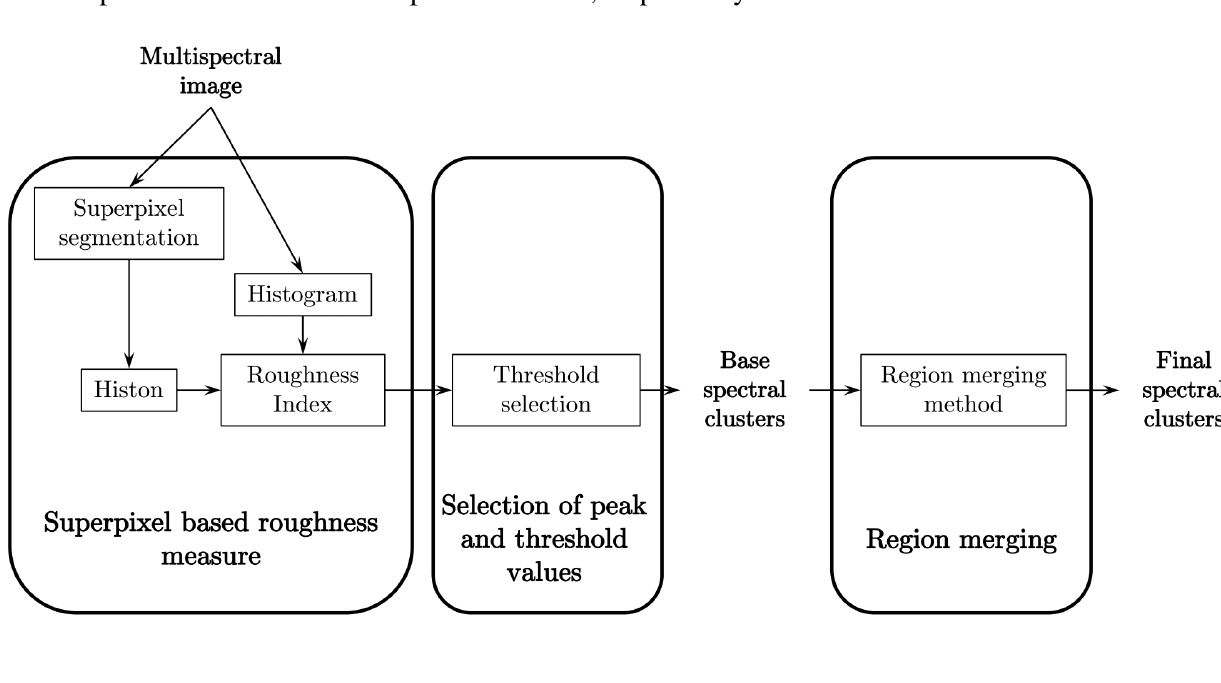
Figure 1. Flowchart of the proposed